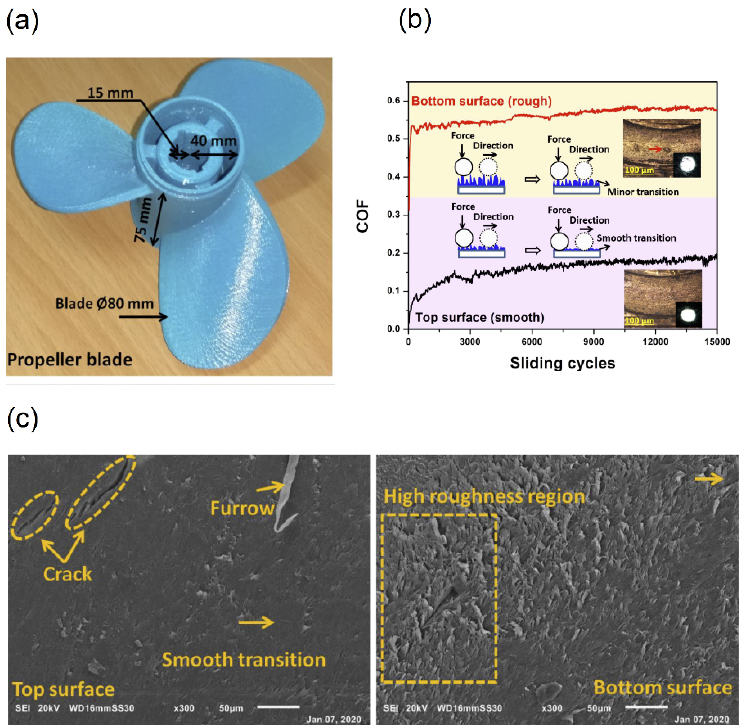
Figure 8. ( a ) 3D printed propeller blade, ( b ) Friction performance of PLA sample at the top and the bottom surface and ( c ) wear microstructure of PLA samples (reprinted with permission from [14]).